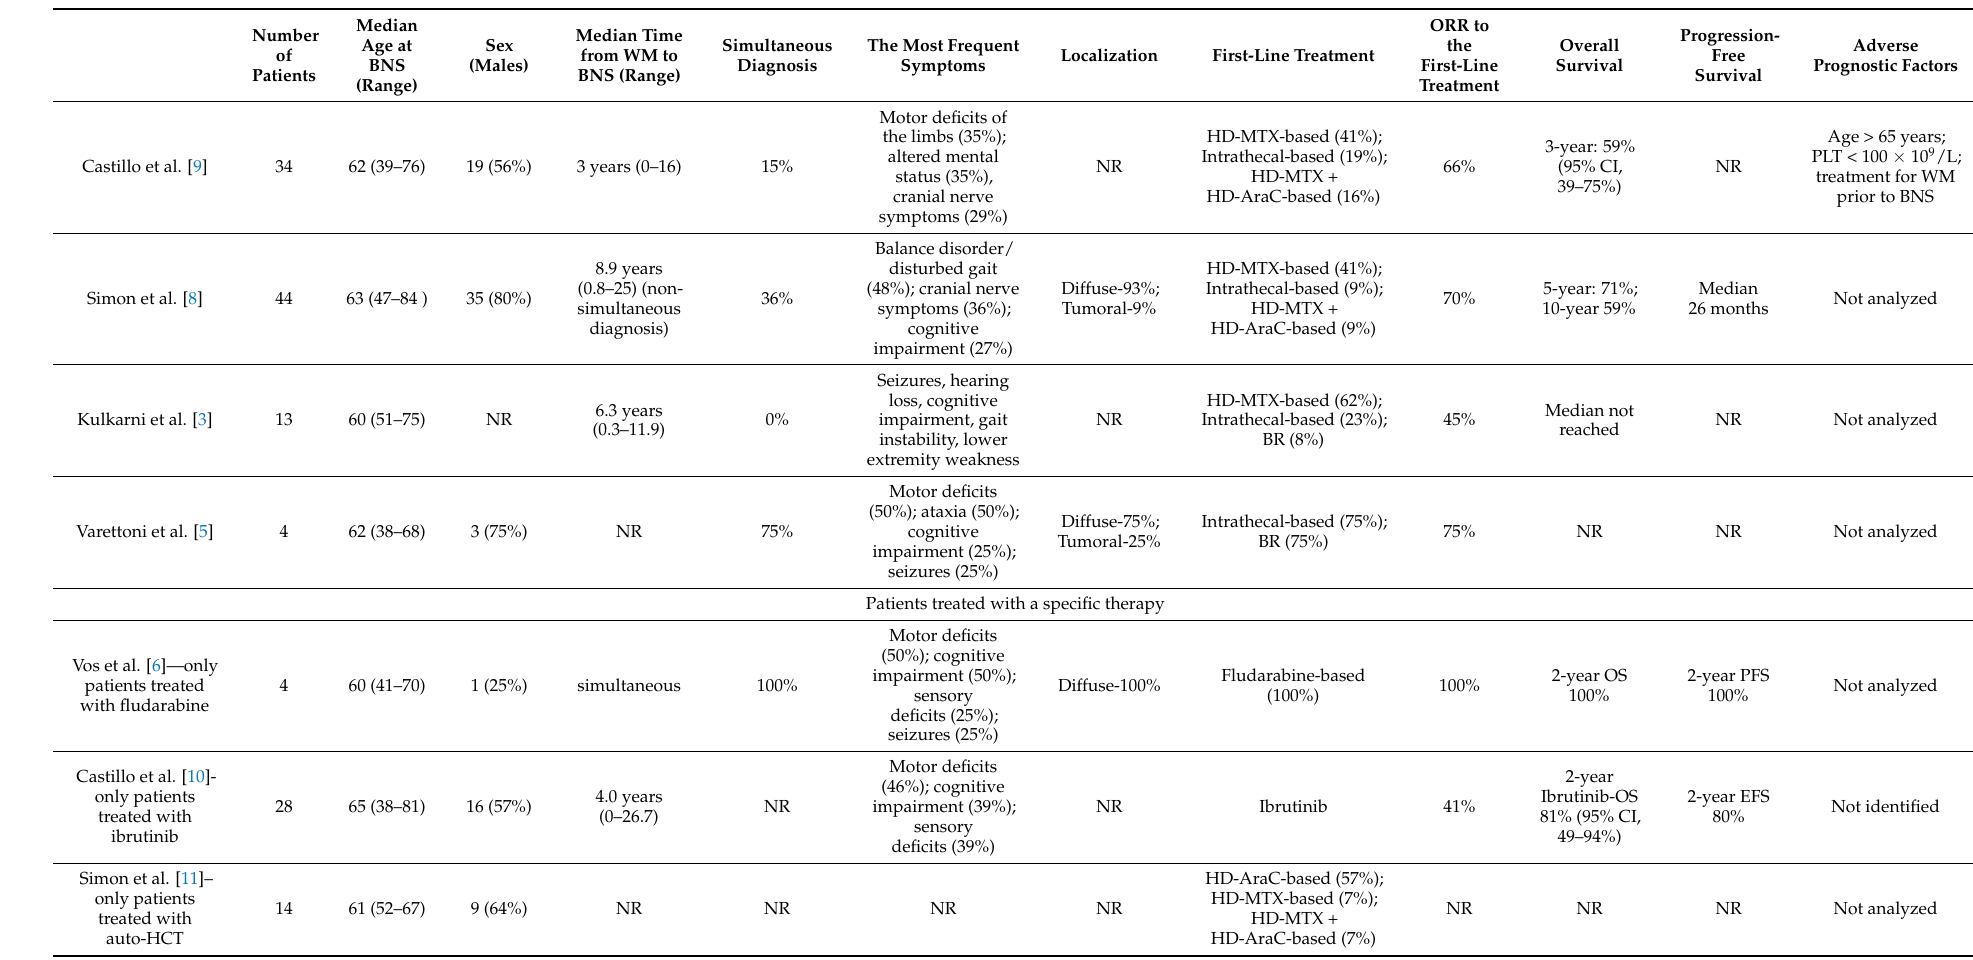
Table 1. Patients’ characteristics (auto-HCT—autologous hematopoietic cell transplantation; BDR—bortezomib, dexamethasone, rituximab; BNS—Bing-Neel syndrome; BR—bendamustine, rituximab; CNS—central nervous system; DRC—dexamethasone, rituximab, cyclophosphamide; ECOG—Eastern